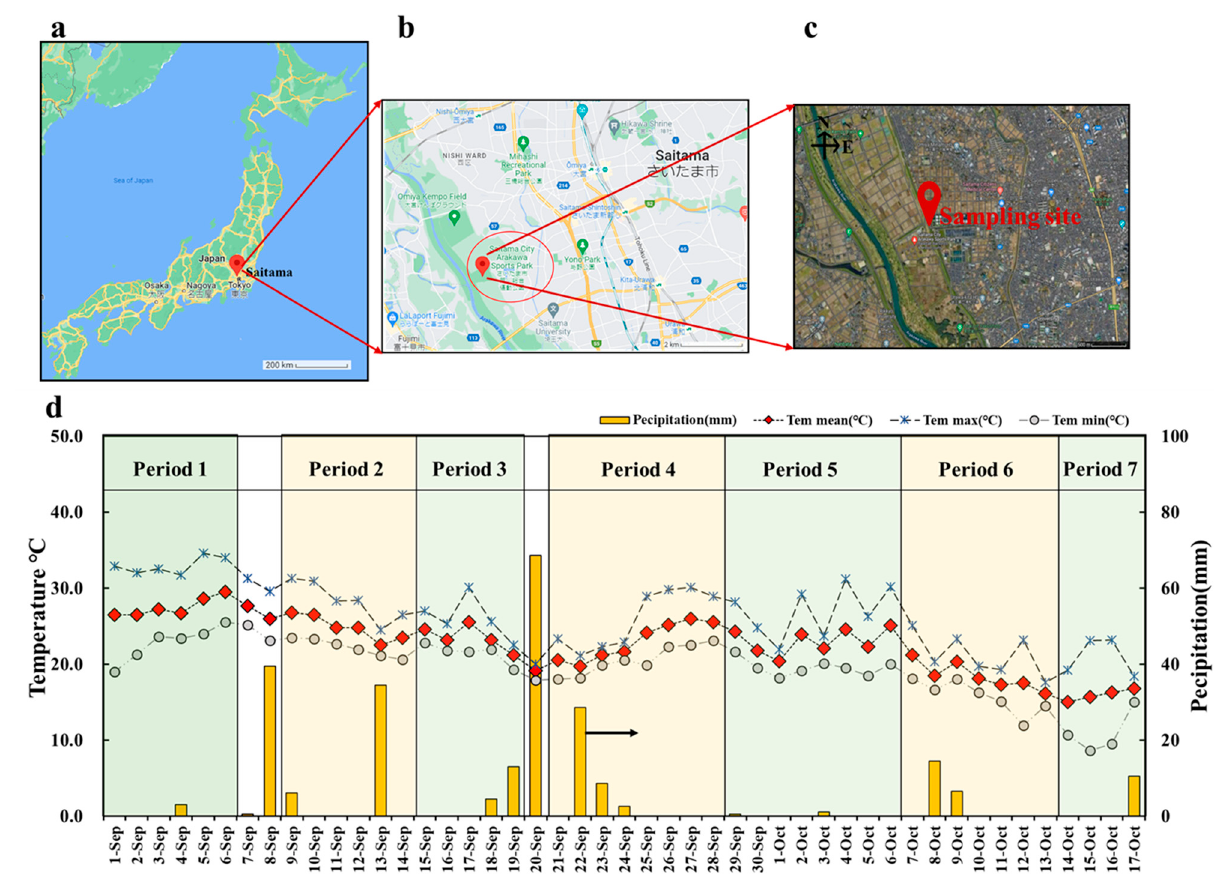
Figure 1. ( a ) The location of Saitama City in Japan; ( b , c ) the location of the sampling sites in the park. These images are from Google Maps. ( d ) The mean, maximum, and minimum temperatures and the precipitation levels over the total sampling period.